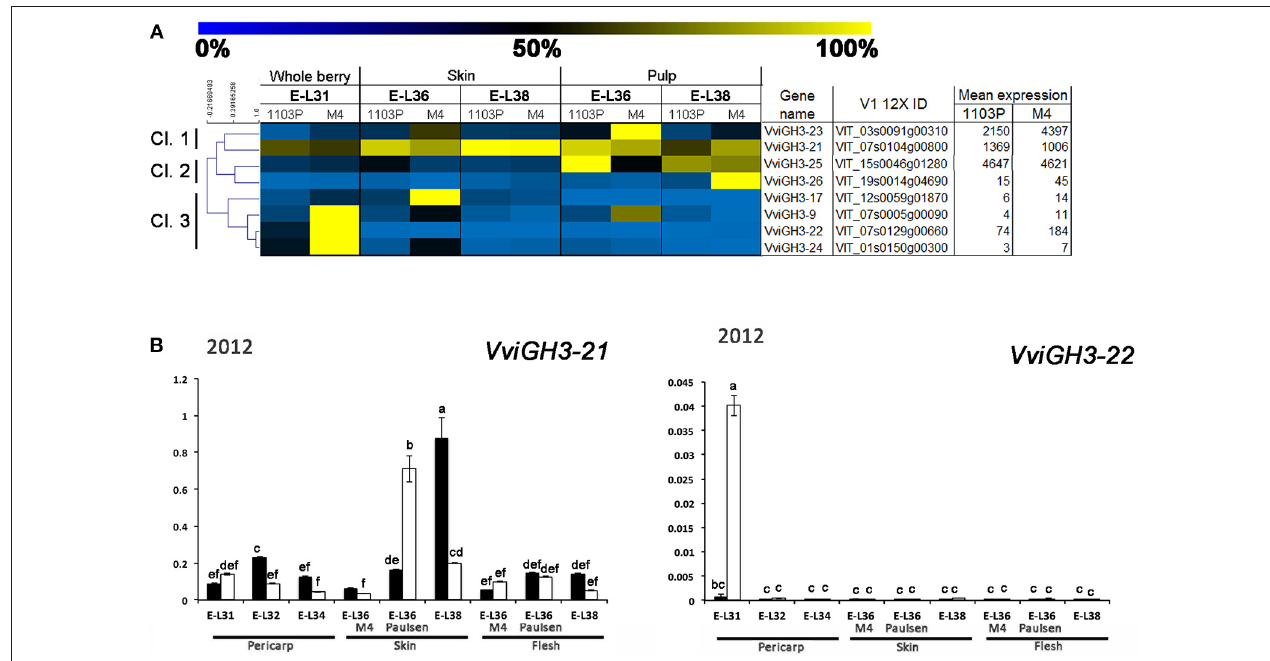
FIGURE 7 | (A) Heat-map showing the expression of VviGH3 genes based mRNA-Seq data. The expression values were calculated as a percentage related to the developmental stage showing the highest expression value (100 and 0% for yellow and blue colors, respectively) within all mRNA-seq datasets considered (E-L31, E-L36, and E-L38). Proposed gene name ( Supplementary Results S1 ), PN40024V1 12X identifier, and mean of normalized counts are also reported. (B) Quantitative RT-PCR analyses on VviGH3-9 and VviGH3-22 in flesh and skin of berries sampled from both 1103P/CS (solid bars) and M4/CS (empty bars) graft combination in 2012 growing season. Results are shown as means and SE for three biological replicates. Bars indicate SE. Different letters indicate statistically significant differences ( P = 0.05 ) by Duncan’s new multiple range